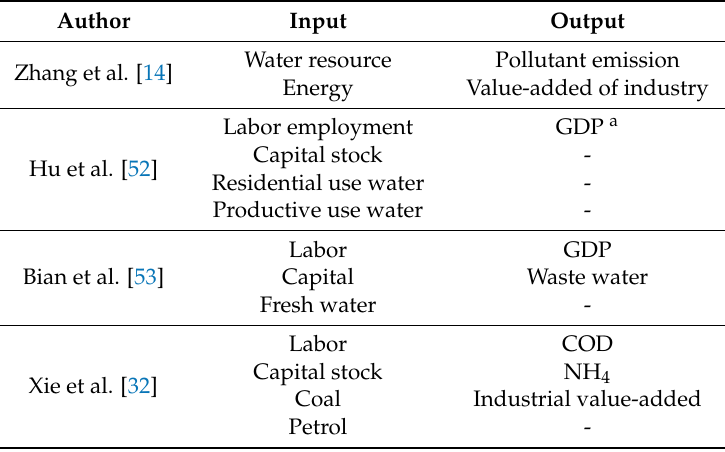
Table 1. Index of previous